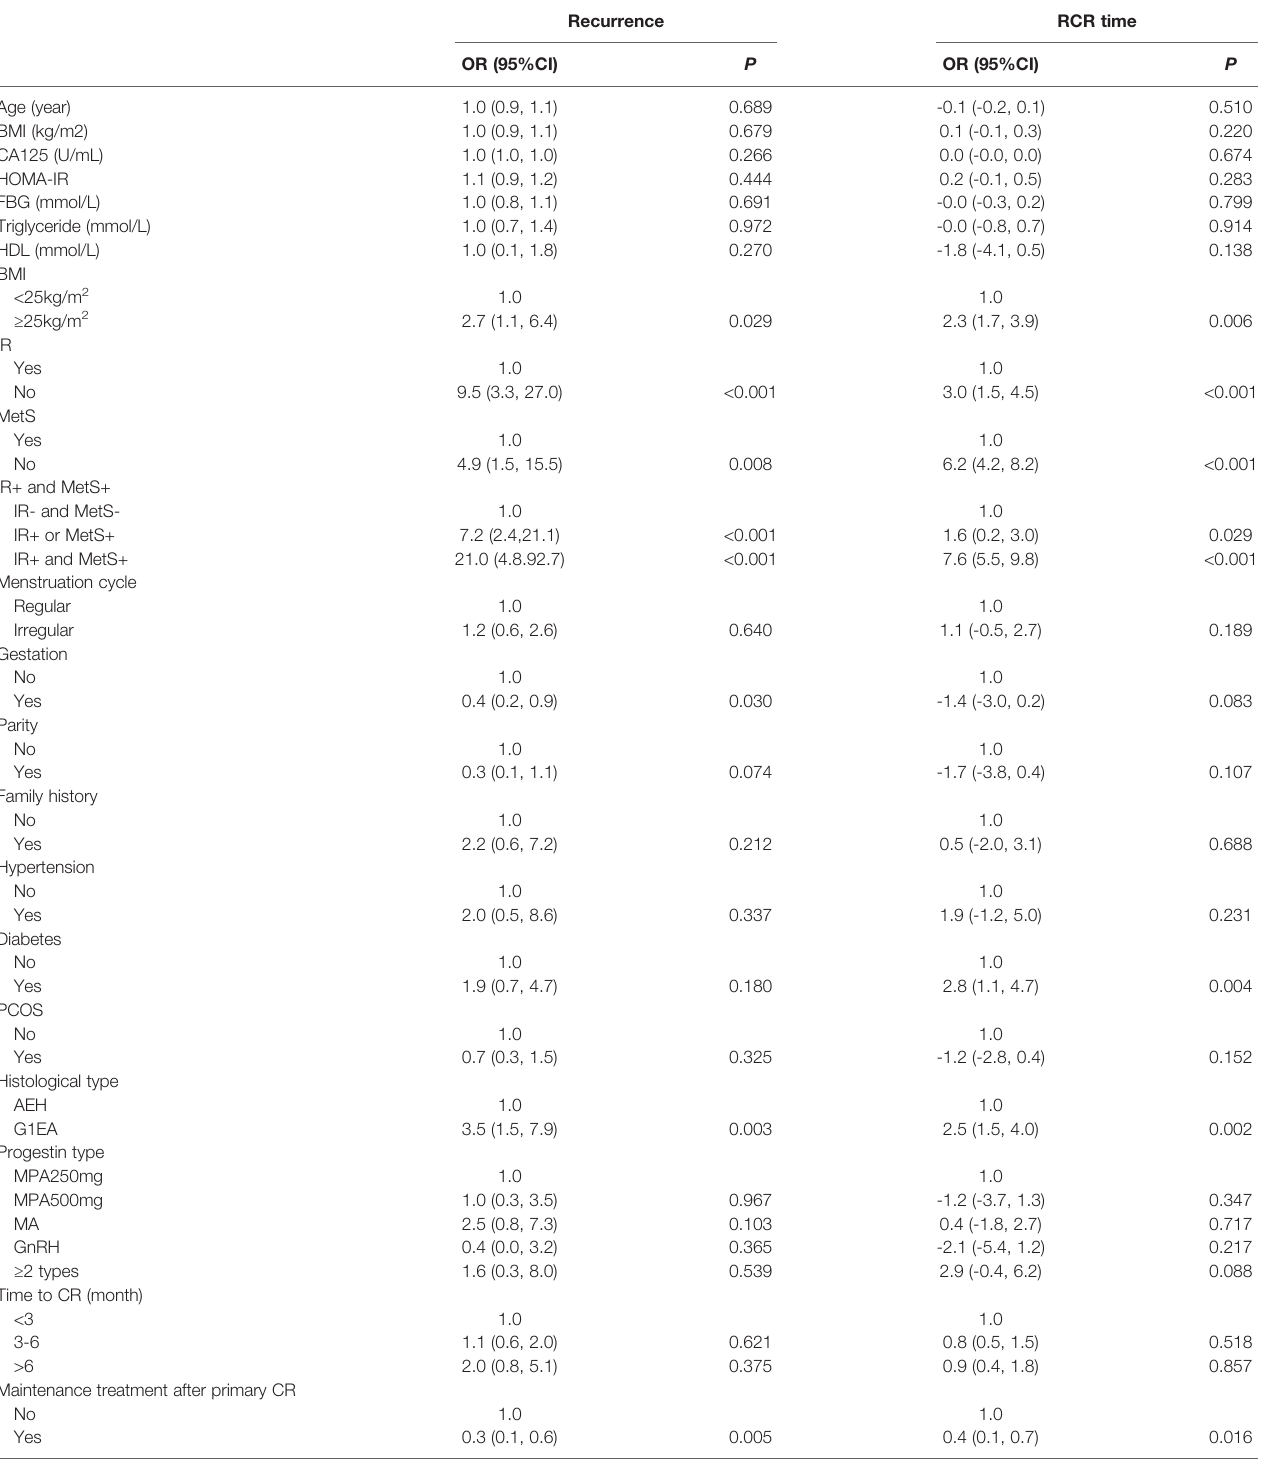
TABLE 2 | Univariate analysis between clinicopathological characteristics and recurrence/RCR